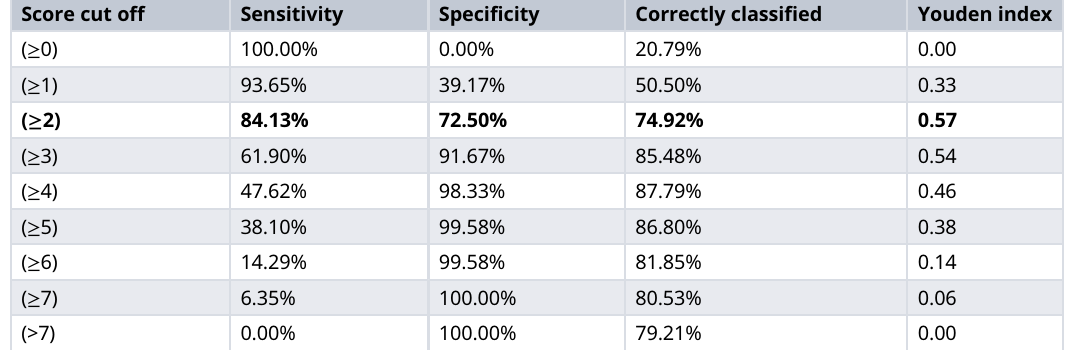
Table 4. Sensitivity and specificity of scores at different cut -off points and Youden